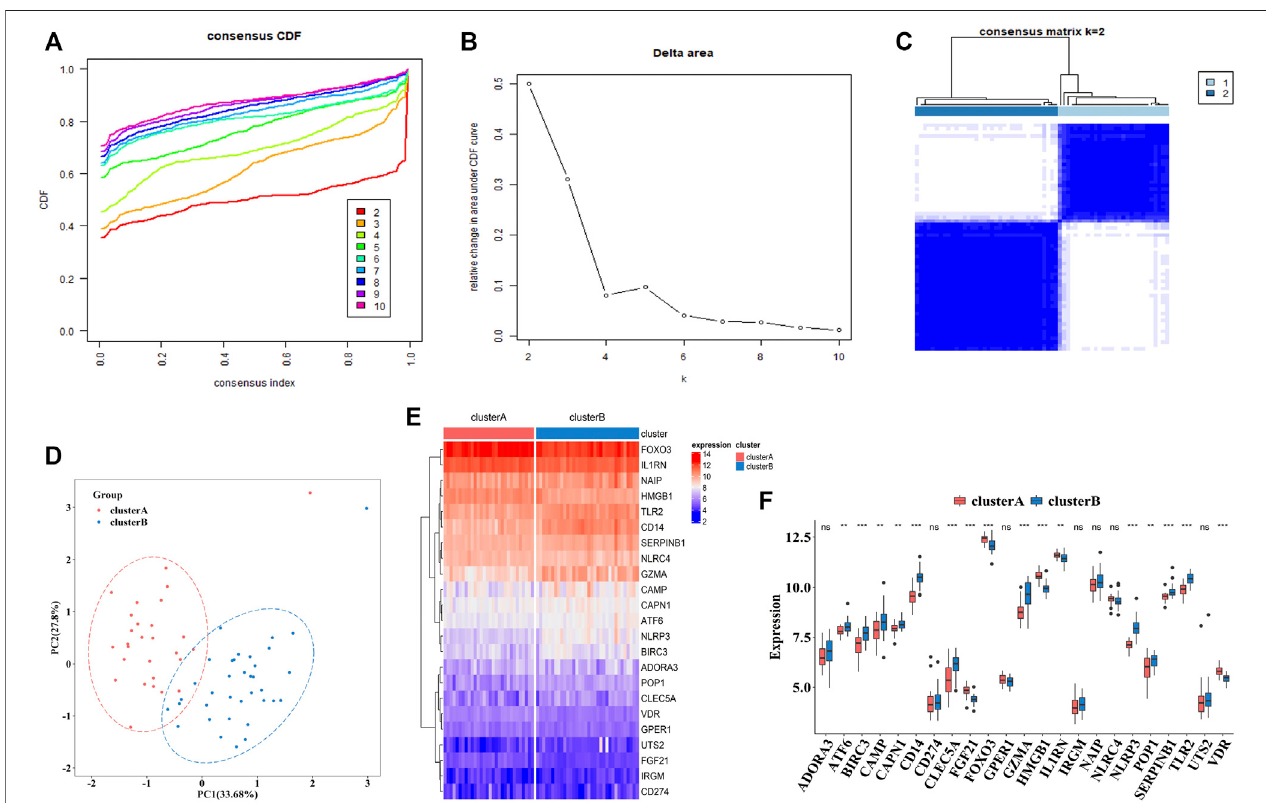
FIGURE 7 | The construction of pyroptosis-related MDD subtypes (A) . The empirical cumulative distribution function (CDF) plots revealed the consensus distributions for each k (k = 2 – 10) (B) . Area change under CDF curve when K = 2 – 10. (C) . Two pyroptosis-related MDD clusters were generated via unsupervised consensus cluster (D) . PCA for the expression pro fi les of the 23 pyroptosis-related genes (E,F) . Expression heat map and boxplot map of the 23 pyroptosis-related genes in cluster A and cluster B. Adjusted p -values were showed as: ns, not signi fi cant; ** p < 0.01; *** p <